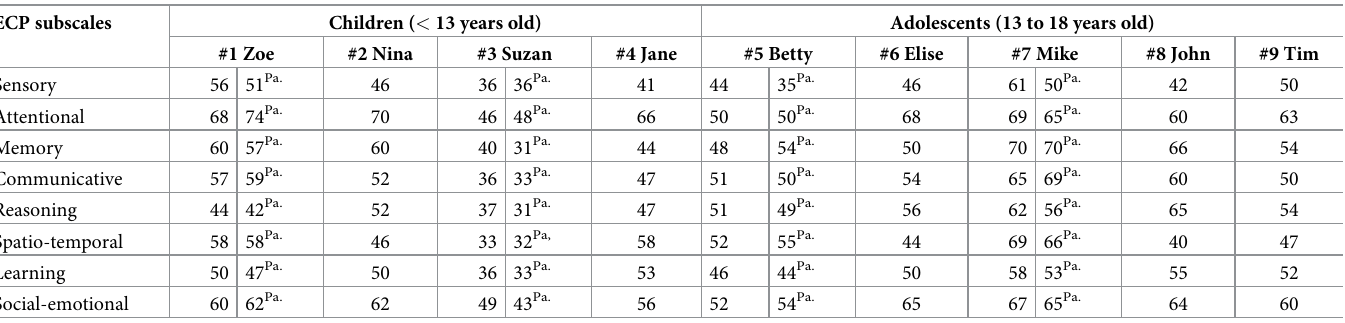
Table 1. Standardized scores ( t -scores) on the ECP Scale of the nine PIMD participants.